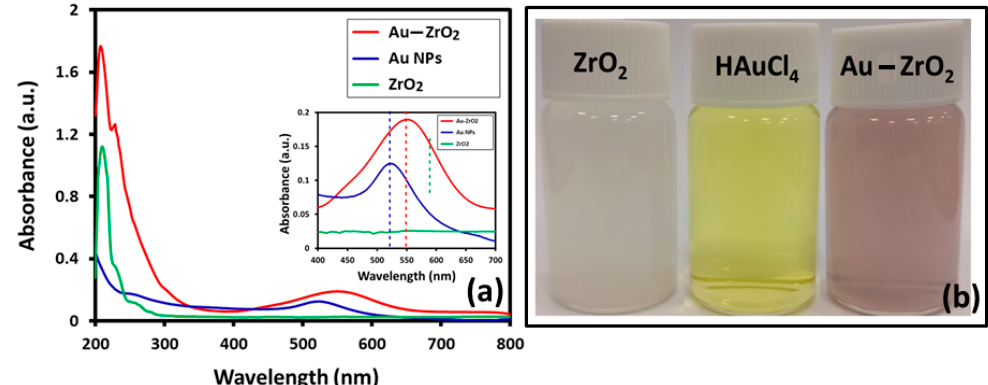
Figure 1. (a) Comparison of the UV-Vis spectra of Au-ZrO 2 with pristine ZrO 2 nanoparticles (NPs) stabilized with benzyl alcohol (b) digital photos of the dispersion of ZrO 2 nanoparticles, HAuCl 4 and Au-ZrO 2 in ethanol.